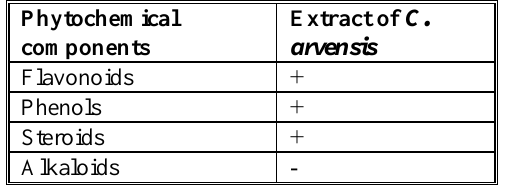
Table 3: Phytochemical analysis of the aerial parts of Convolvulus arvensis extract.